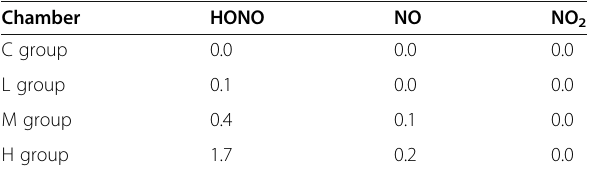
Table 1 Concentrations of nitrogen oxides in animal exposure